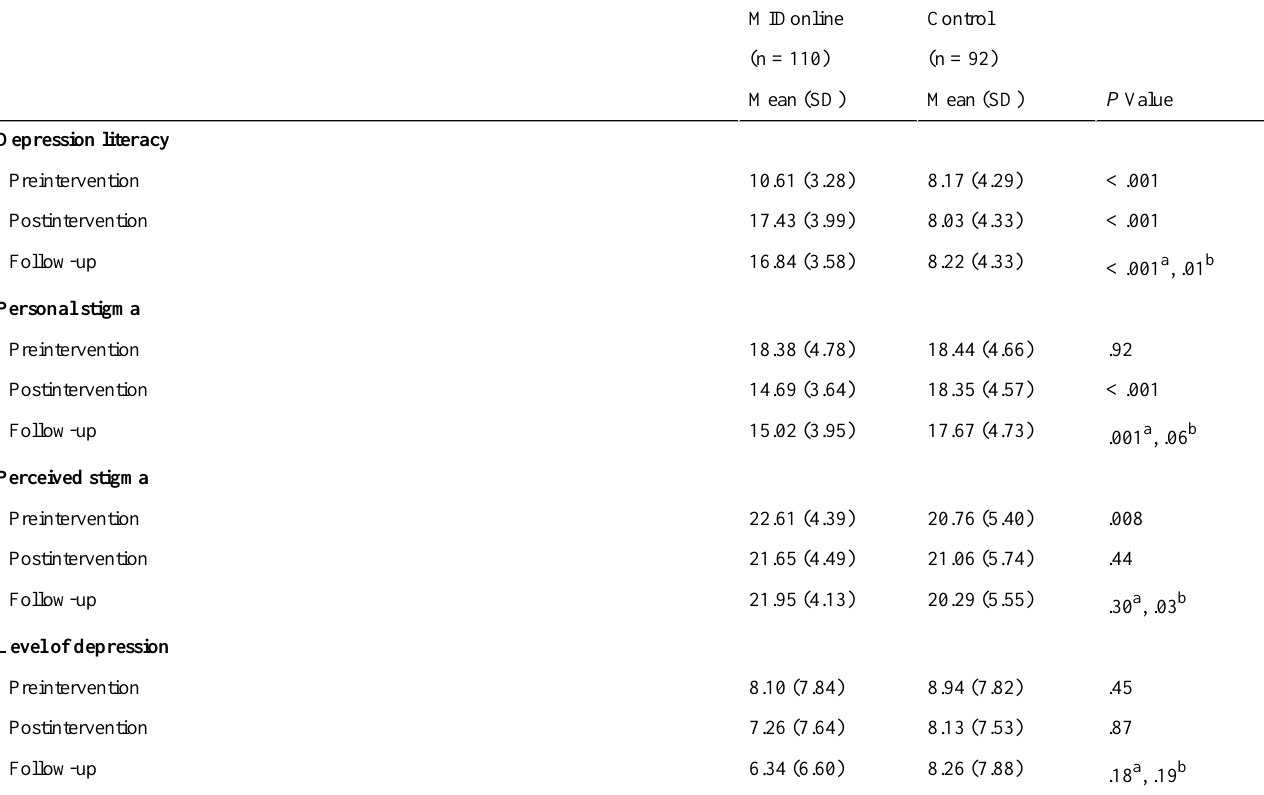
Table 2. Mean depression literacy, personal and perceived stigma and level of depression scores for each intervention group over time and